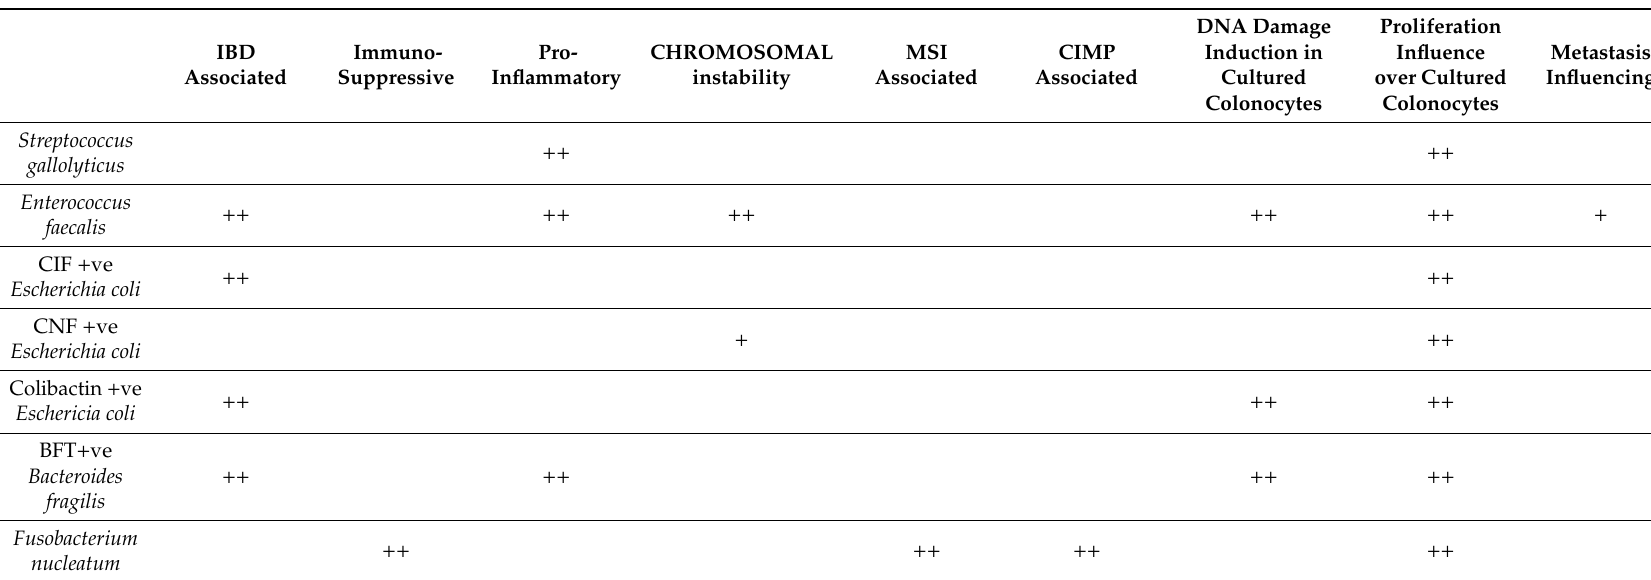
Table 1. Mechanistic evidence underpinning the putative role of tumour-associated gut bacteria in colorectal carcinogenesis. + suggestive evidence, ++ multiple strands of